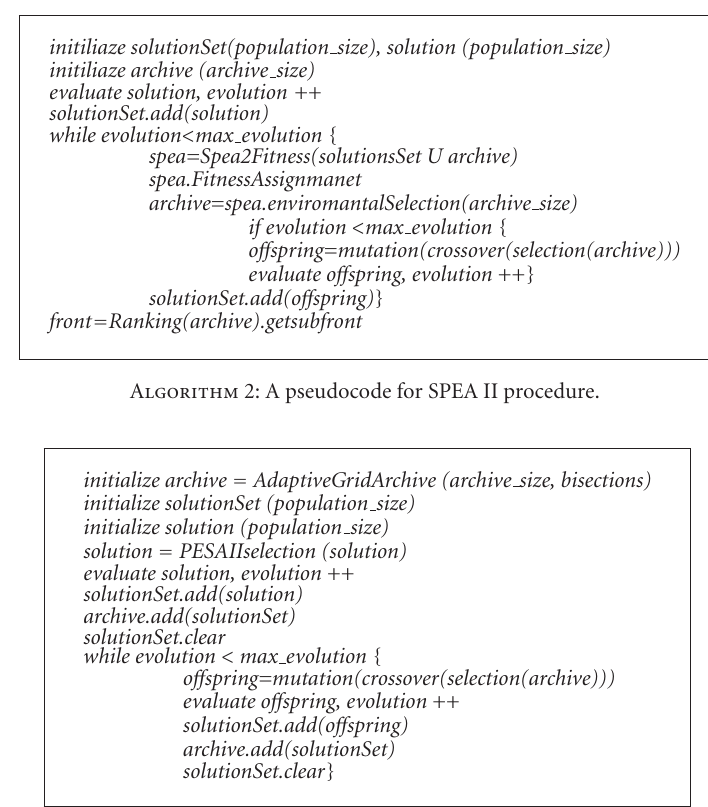
Algorithm 3: A pseudocode for PESA II